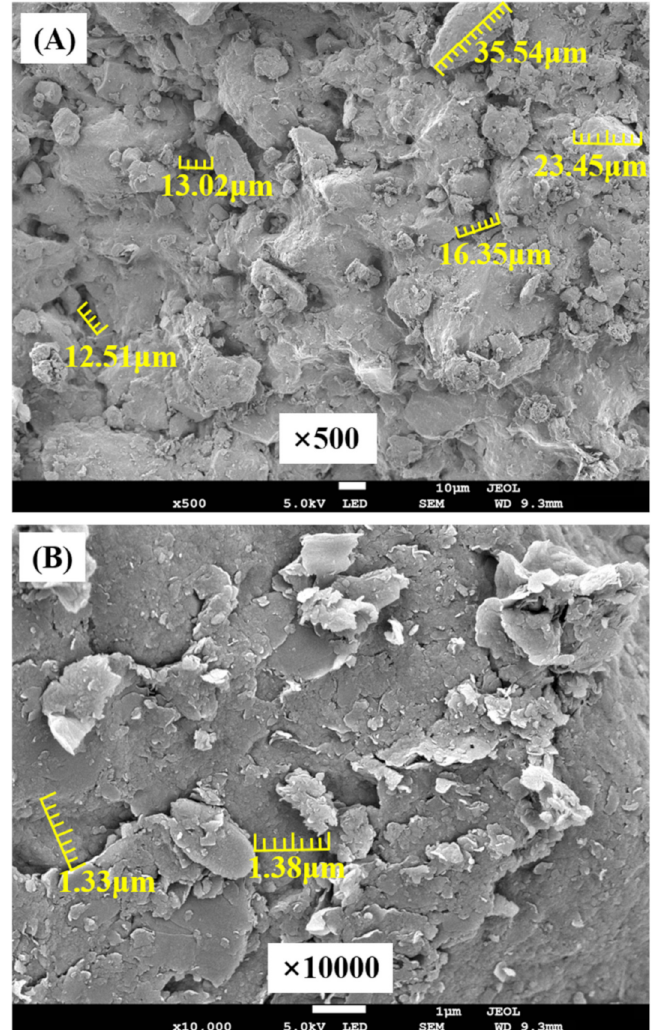
Figure 15. SEM pictures of the filter cake. It was observed at the same position at different magnifica- tions. ( A ) magnified 500 times; ( B ) magnified 10,000